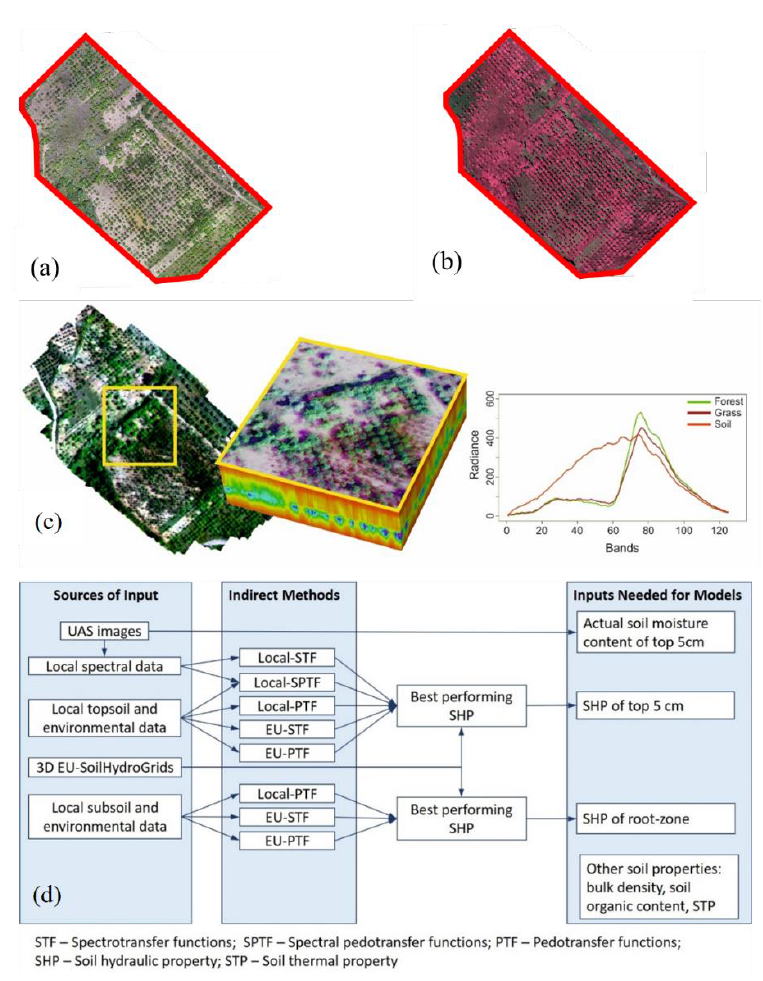
Figure 9. ( a ) a RGB image taken on 13 June 2019, 12:23, MFC2-Alento; ( b ) a multispectral image (Band1 NIR (Near Infrared), Band2 Red, Band3 Green) taken on 13 June 2019 at 15:42, MFC2-Alento; ( c ) a hyperspectral image in RGB colors with the hyperspectral data cube and mean spectral curves of forest, grass, and soil features taken on 15 June 2019, between 9:50 and 10:30, MFC2-Alento; ( d ) the workflow on the combined use of different sources of data to produce soil texture information and corresponding soil hydro-thermal properties. (EU-STF-LUCAS -spectrotransfer functions derived based on the European Spectral Soil Library [93] ; 3D EU-SoilHydroGrids – Soil Hydraulic Database of Europe at 250 m [91] , EU-PTF - EU-HYDI – pedotransfer functions derived based on the European Hydropedological Data Inventory [96] .